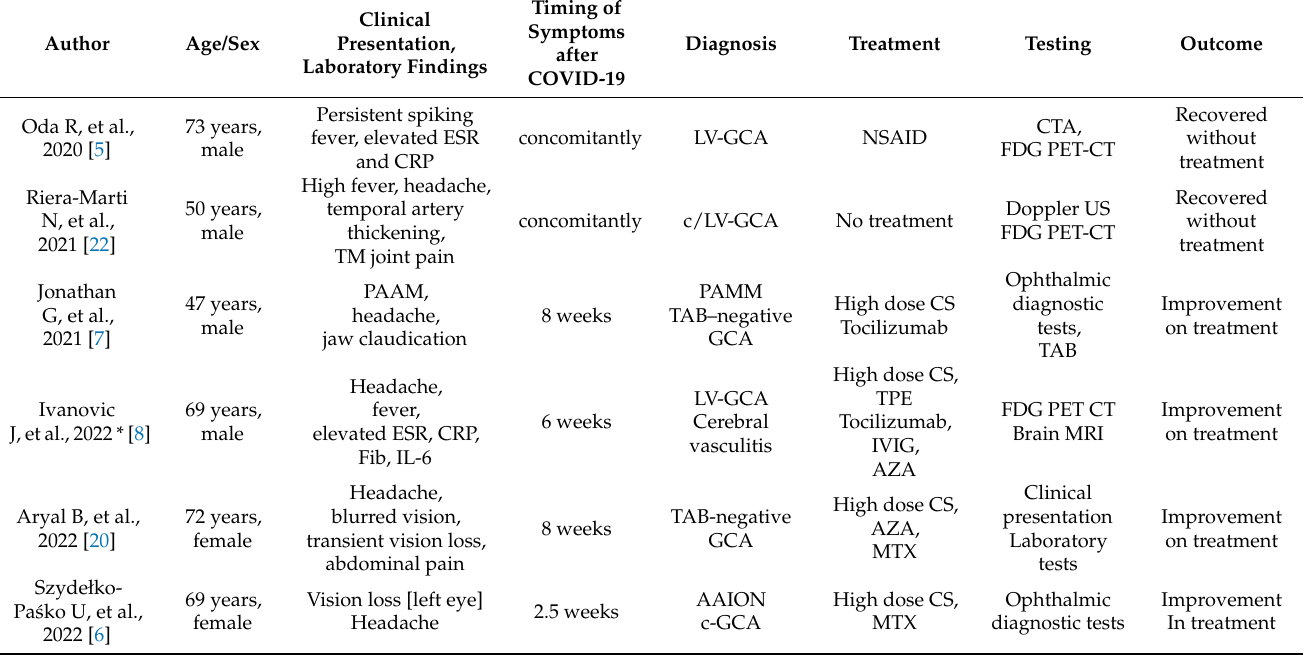
Table 1. Cases of LVV associated with COVID-19: clinical, laboratory features and